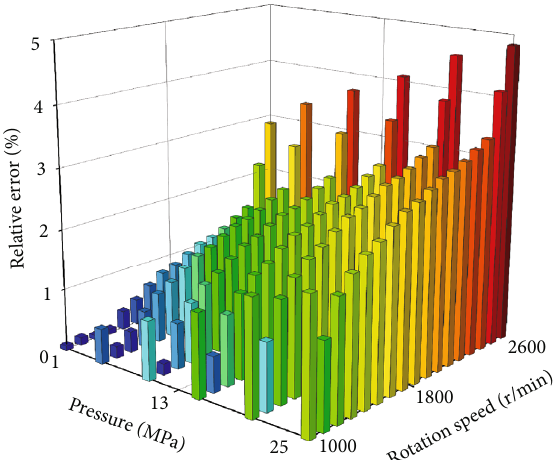
Figure 11: The relative error between theoretical results and simulation results.